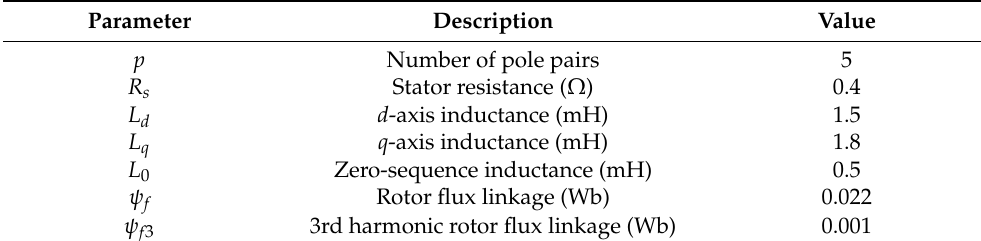
Table 1. TPSW-PMSM